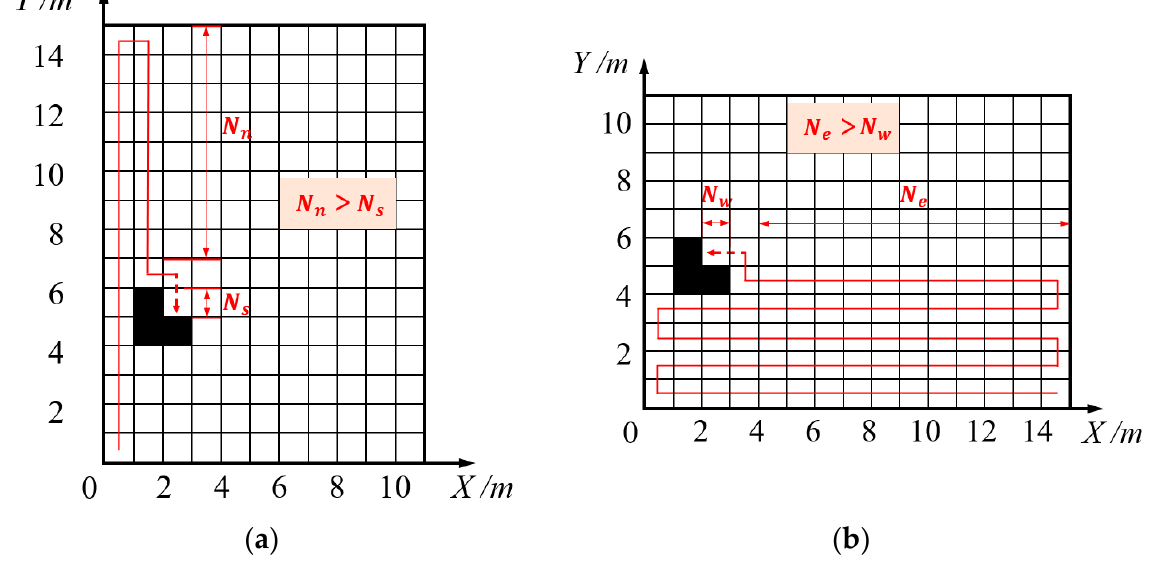
Figure 8. Conventional obstacle avoidance strategy: ( a ) longitudinal and ( b ) transverse reciprocat- ing motion.